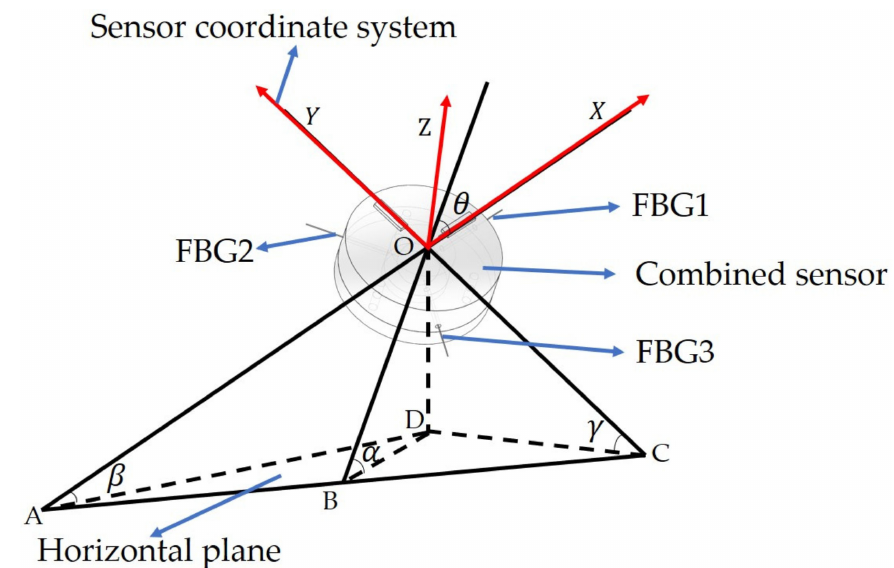
Figure 3. Schematic diagram of pitch and roll angle of the sensor coordinate system with the horizontal plane. The three FBGs are marked as FBG1, FBG2, and FBG3, respectively. The X-axis is the mounting direction of FBG1. In the platform plane, the Y-axis represents the direction of FBG1 rotated 90 degrees counterclockwise. The Z-axis is perpendicular to the plane of the combined sensor. α is the angle between the plane of the combined sensor and the horizontal plane. θ is the angle between the X-axis and line OB. β (pitch angle) is the angle between the X-axis and the horizontal plane. γ (roll angle) is the angle between the Y-axis and the horizontal